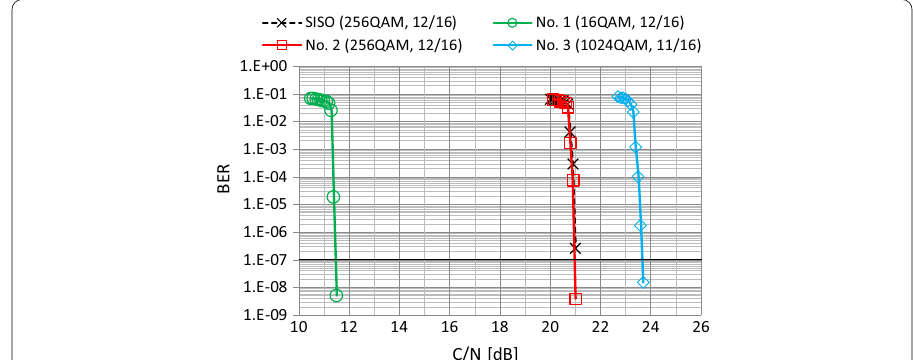
Fig. 10 BER characteristics in ideal AWGN channel in laboratory experiments